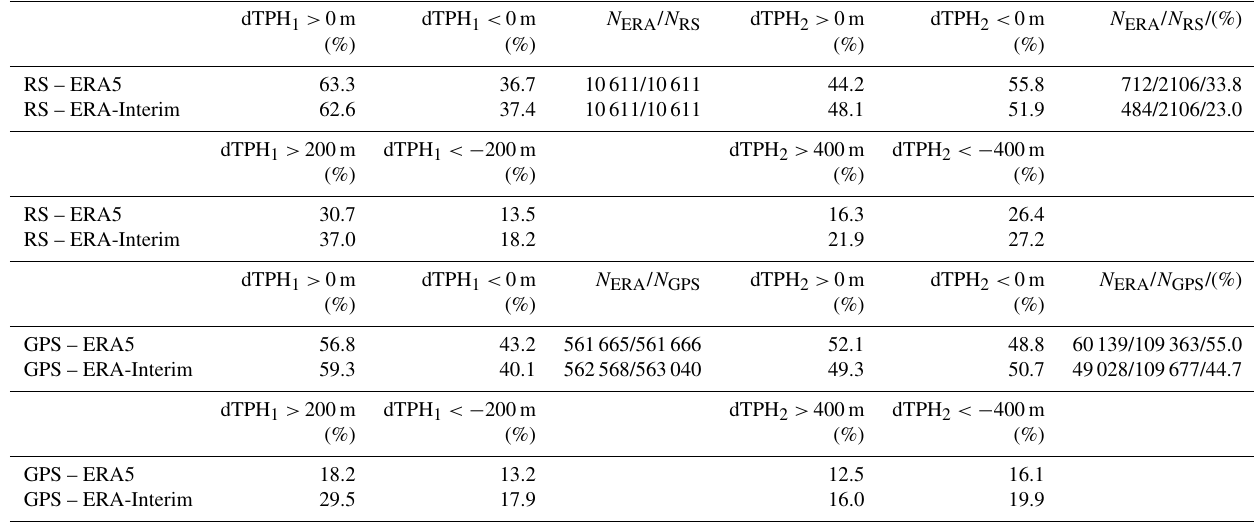
Table 1. Summary of tropopause height differences between ERA5 and ERA-Interim with radiosonde (RS) and GPS